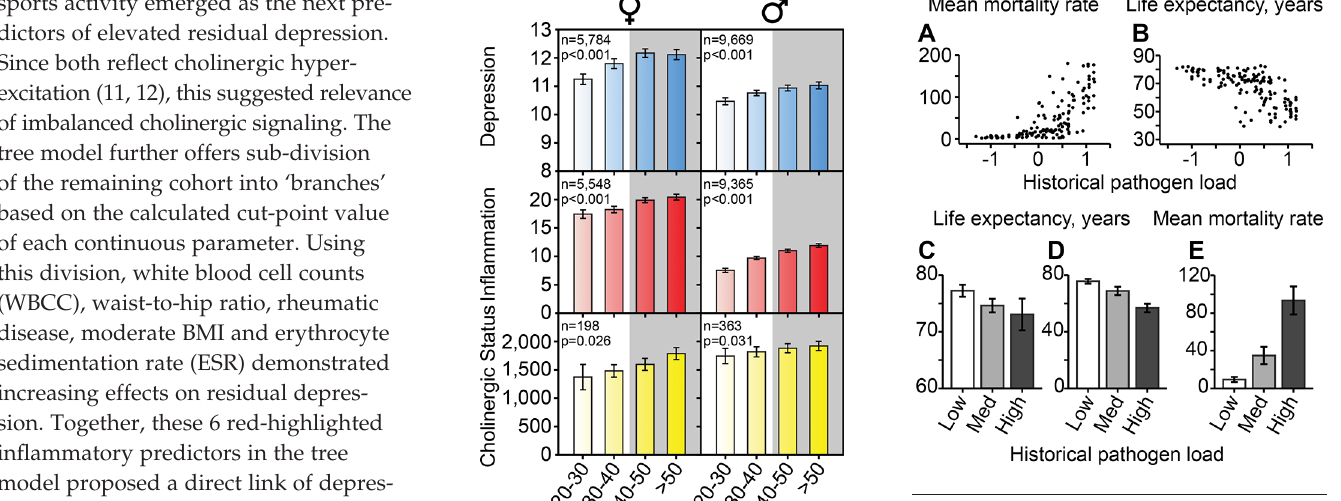
(per 1,000 live births) scores ( p <